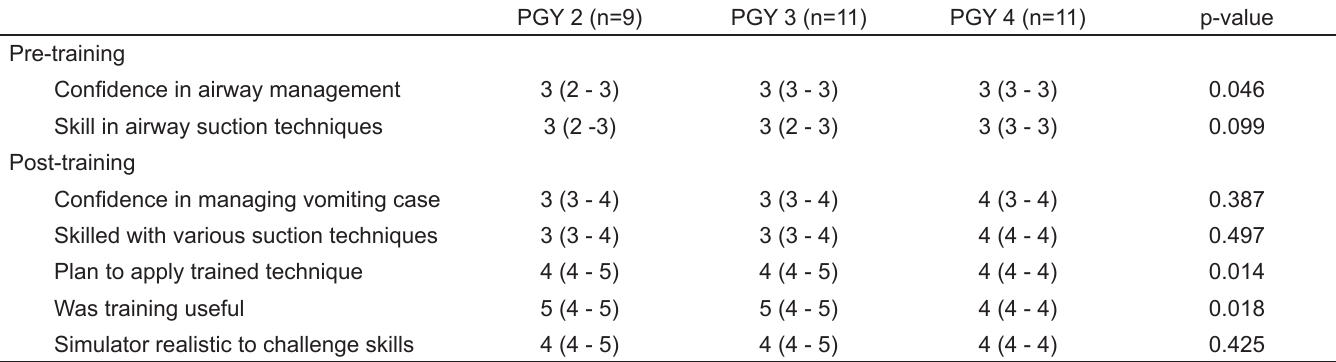
Table 4. Survey Analysis Based Off PGY Status.